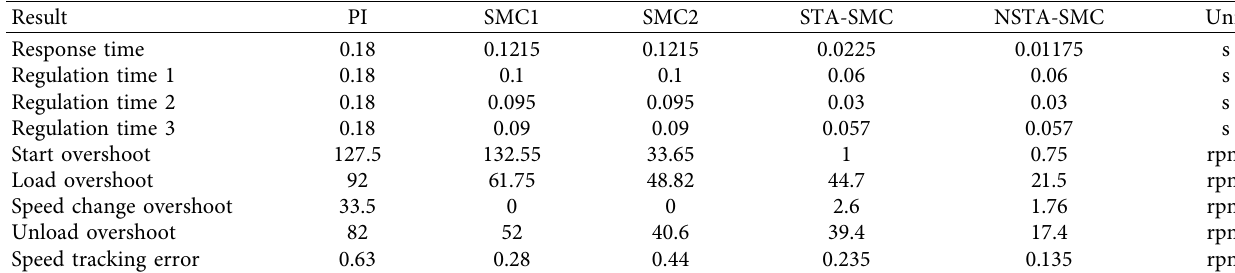
Figure 3: Enlargement of local speed (a). Table 2: SPMSM system